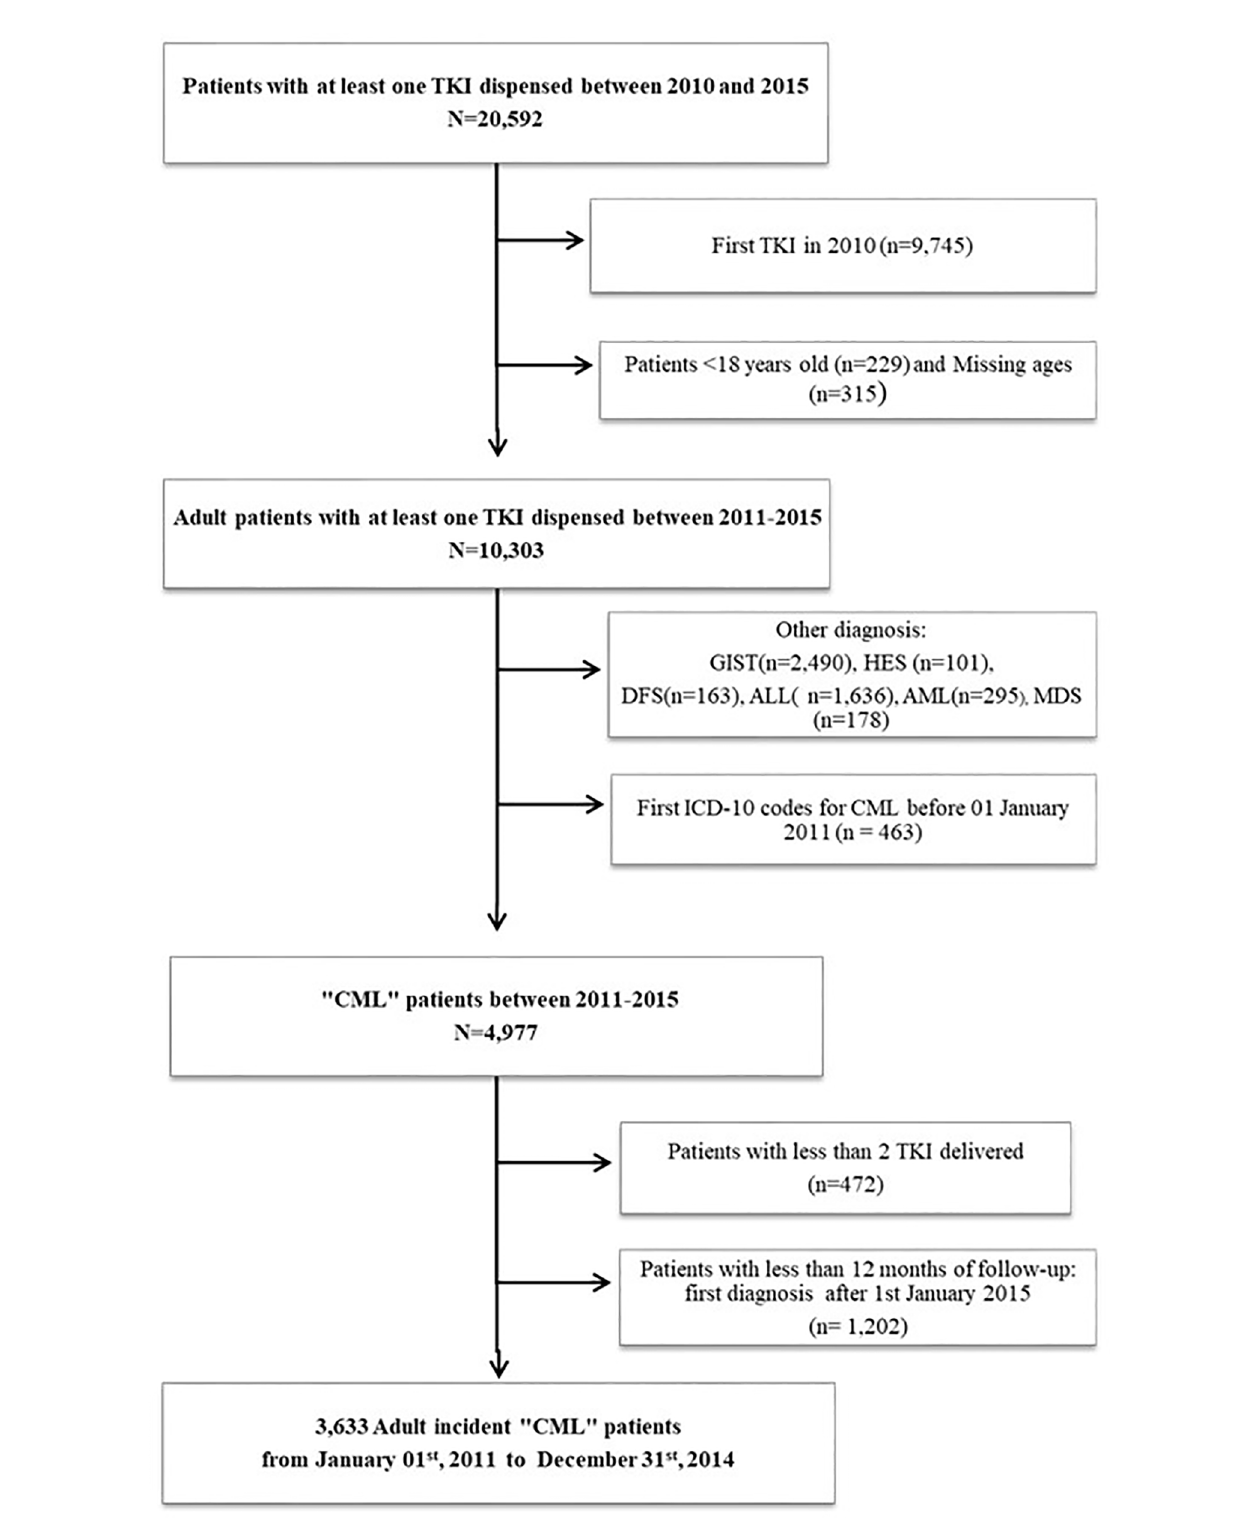
FIGURE 1 | Flowchart illustrating patients ’ selection. TKI, Tyrosin Kinase Inhibitor; CML, Chronic Myeloid Leukemia; GIST, Gastrointestinal Stromal Tumors; HES, Hypereosinophilic Syndromes; DFS, Dermato fi brosarcoma; ALL, Acute Lymphoblastic Leukemia; AML, Acute Myeloid Leukemia; MDS, Myelodysplastic Syndromes.